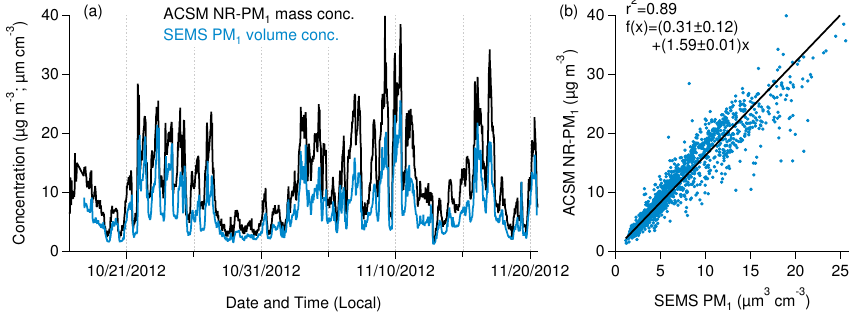
Figure 3. (a) Time series and (b) correlation of total aerosol mass measured by ACSM (NR-PM 1 ) and SEMS DMA/MCPC during period of 17 October to 20 November, 2012. Aerosol density was estimated from the linear regression slope of 1.59 multiplied by 1.10 to account for the 10% of elemental carbon (EC) component that is not measured by ACSM. This results in estimated aerosol density of 1.75gcm − 3 . Previous comparison of SO 2 −